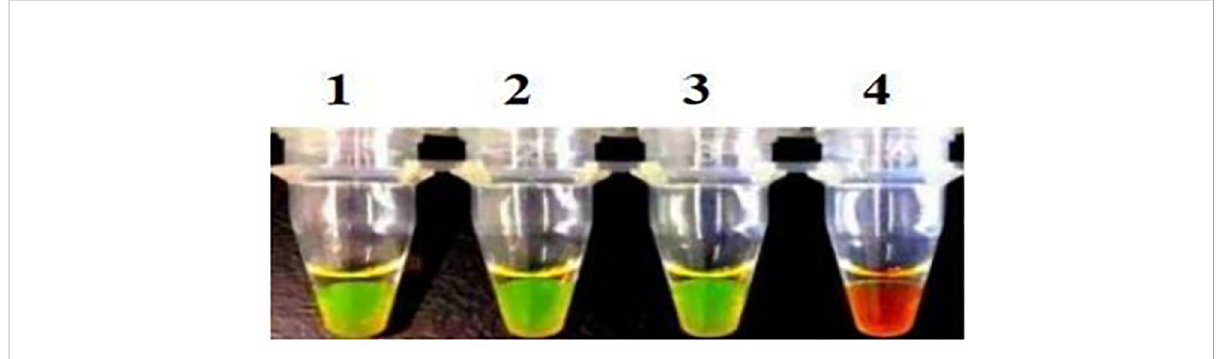
FIGURE 8 Repeatability detection of the LAMP assay for the detection of Brucella suis 52 vaccine strain. Assay products were visualized using color change. Pipe 1-3, three different batches of reagents. Fluorescent green indicates presence of the amplicon while orange indicates no ampli fi cation. The main components of the three batches of reagents are identical, but they are produced at different